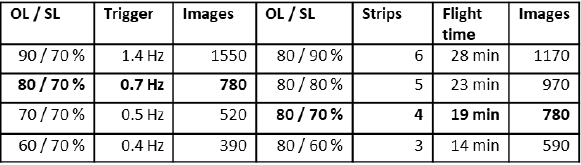
Tab. 1: Influence of forward and side overlap (OL/SL) on relevant mission parameters